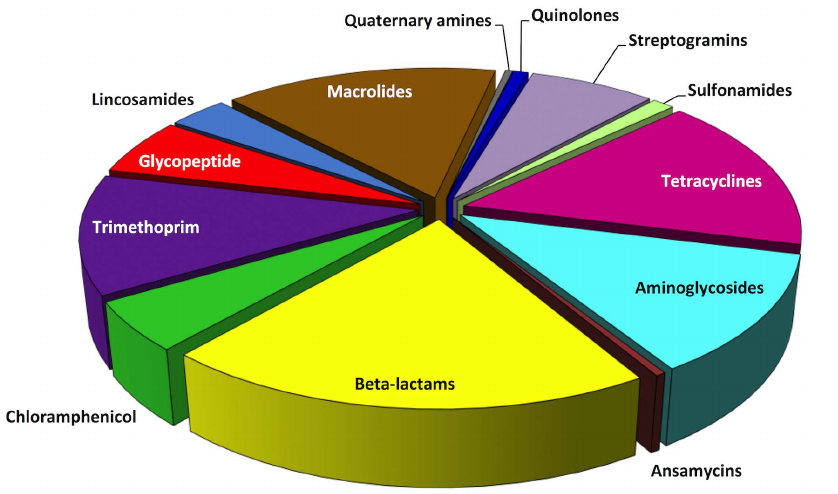
Figure 1. ARDM content allocations for genes conferring resistance to different classes of antimicrobial compounds. Two hundred thirty-nine different resistance determinants are represented by probes on each sub-array.